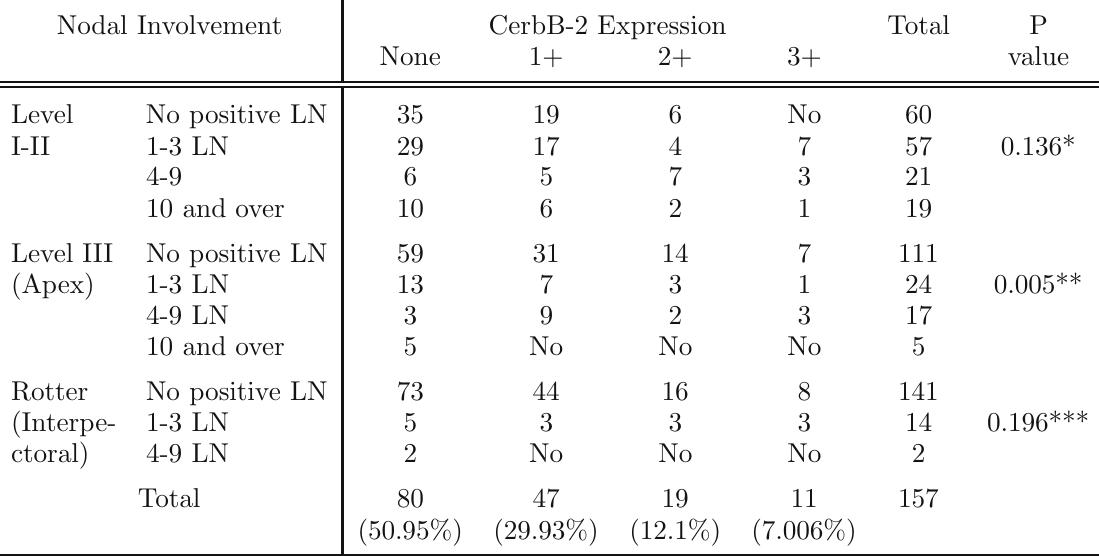
Table 3 Distribution of lymph node involvement according to CerbB-2